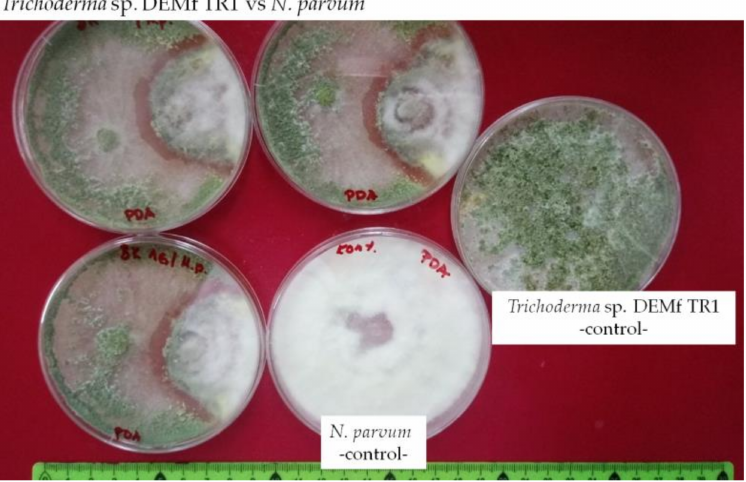
Figure 2. Plate confrontation assay of Trichoderma sp. DEMf TR 1 and Neofusicoccum parvum